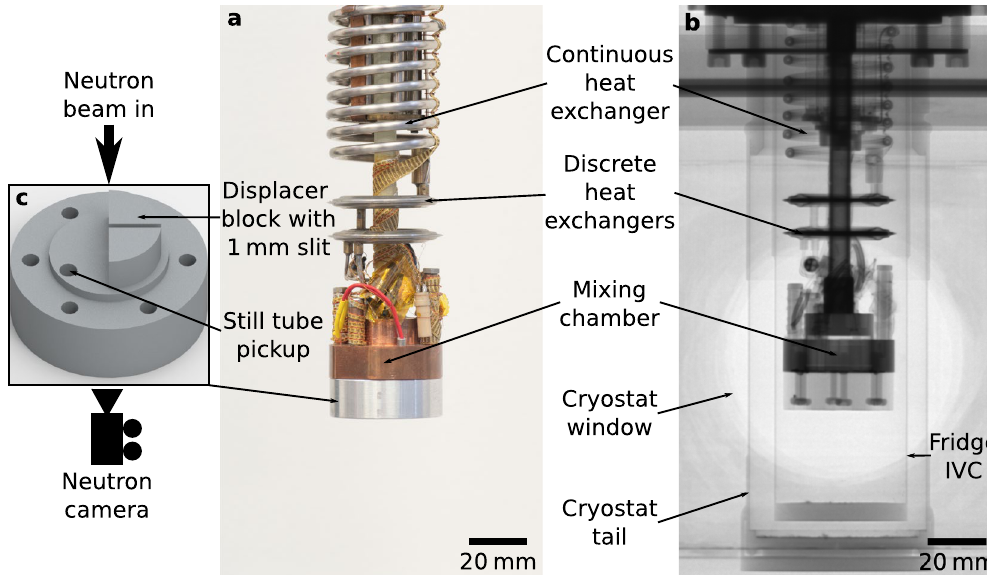
Figure 1. The dilution refrigerator used for this study. ( a ) The dilution insert as viewed under visible light, and ( b ) shows it, to the same scale, under neutron imaging using the IMAT instrument. ( c ) The base of the mixing chamber used for this investigation. This features a displacer block with a 1 mm gap to allow imaging of the helium mixture without the excessive absorption associated with neutrons passing through mixture over the